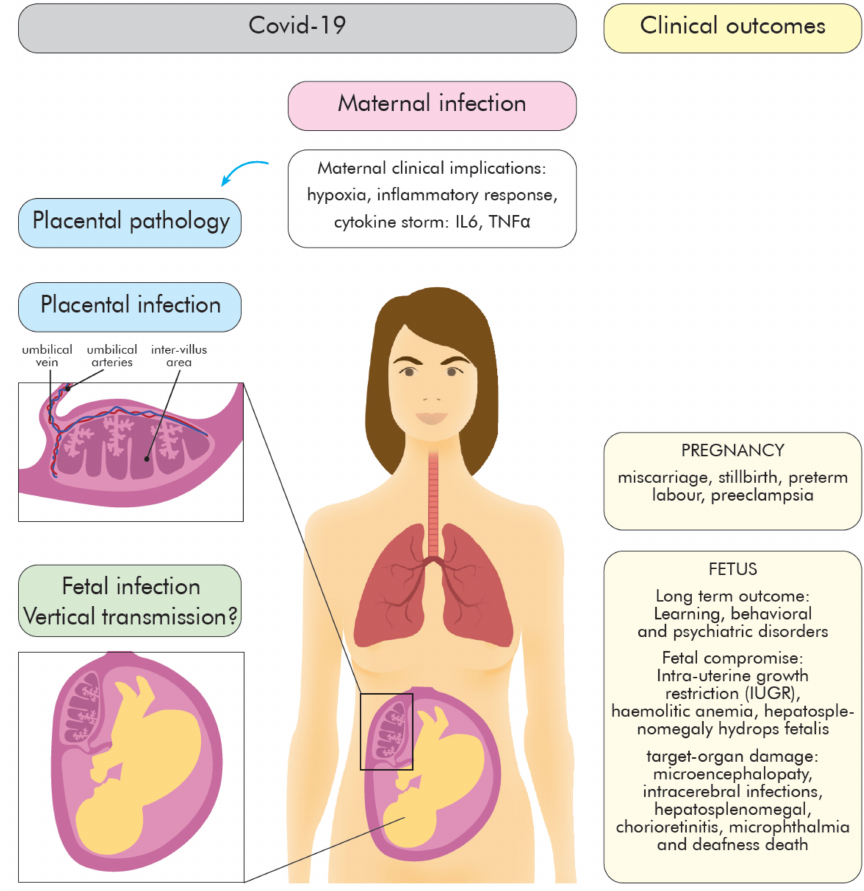
Figure 1. Implications of SARS-CoV-2 virus infection at the maternal–fetal interface. The placental function disruption (histomorphological alterations) as a consequence of maternal clinical implica- tions of COVID-19 (e.g., hypoxia, cytokine storm) and/or placenta infection, as well as probable fetal infection (vertical transmission) may result in pregnancy complications, compromise fetal health and long term adverse neonatal